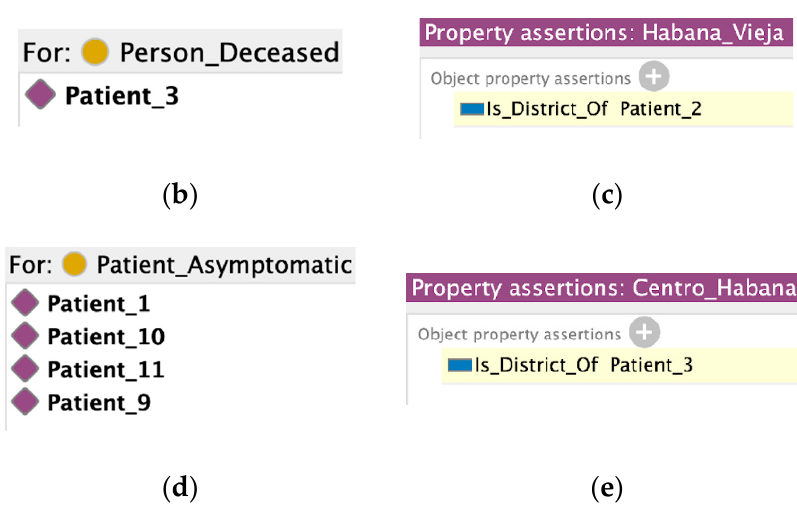
Figure 5. Representation of patient information : ( a ) Individuals of the class Man ; ( b ) Individual of the class Person_Deceased ; ( c ) District of Patient_2 ; ( d ) Individuals of the class Patient_Asymptomatic ; ( e ) District of Patient_3 .